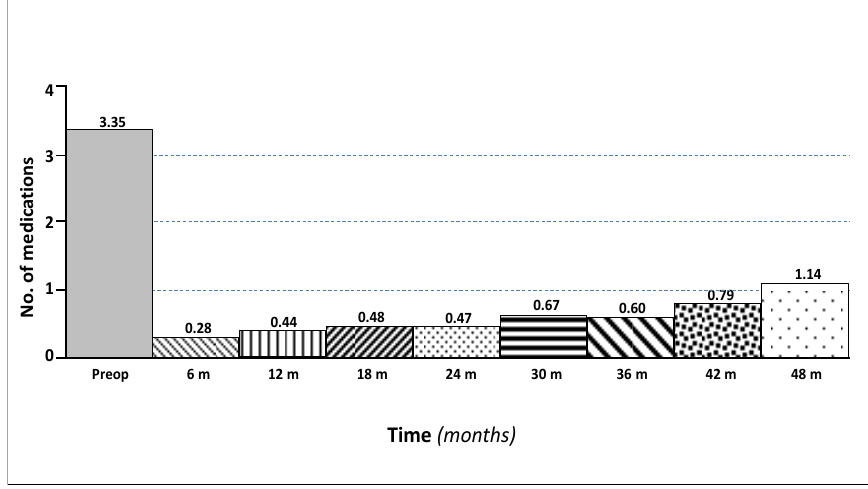
Figure 2. Number of medications at baseline and over a four-year follow-up. The preoperative and three-year postoperative IOP values are plotted in Figure 3.